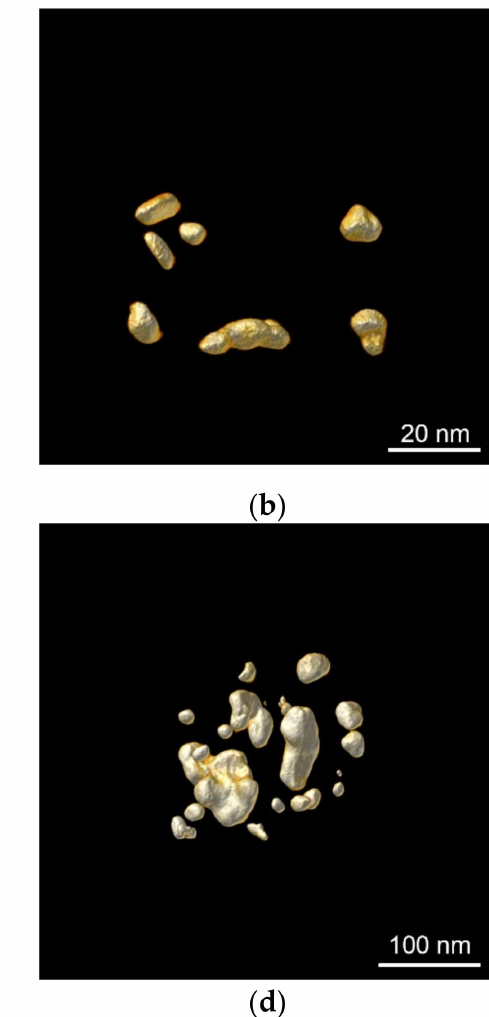
Figure 3. Typical 2D HAADF-STEM and reconstructed 3D images of the powderised beads of the Al 2 O 3 -supported metal catalysts. ( a ) 2D image of the 10 wt% Ru/Al 2 O 3 , ( b ) reconstructed 3D image of the Ru particles on Al 2 O 3 , ( c ) 2D image of the 10 wt% Co/Al 2 O 3 , and ( d ) reconstructed 3D image of the Co particles on Al 2 O 3